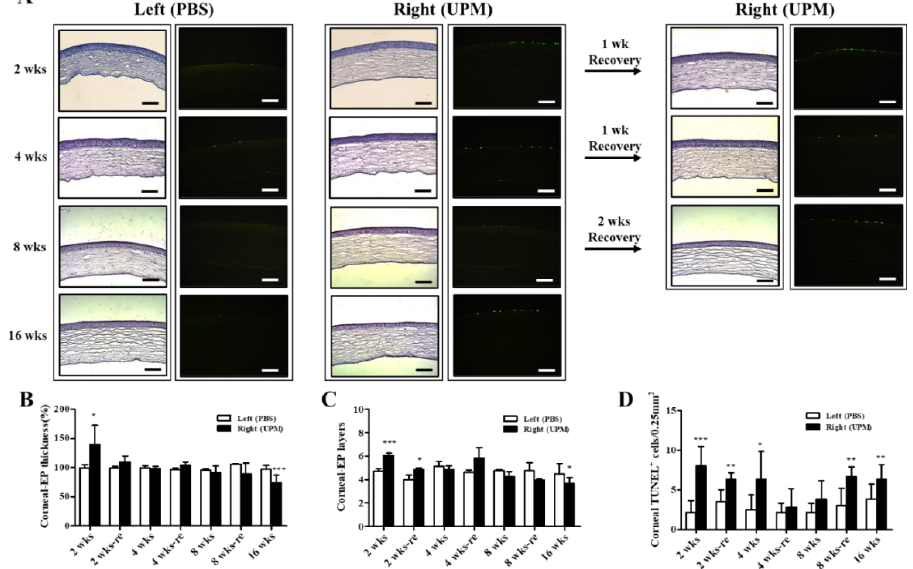
Figure 5. Effect of UPM exposure on corneal epithelial thickness and cell apoptosis according to exposure period. ( A ) Corneal images of hematoxylin and eosin (H&E) and terminal deoxynucleotidyl transferase dUTP nick end labeling (TUNEL) staining acquired at 200× magnification from all experimental periods are shown. The scale bars indicate 100 μm. The graphs of the relative thickness of corneal epithelium ( B ), the number of corneal epithelial layers ( C ) and the counts of apoptotic cells ( D ) are presented. Data are expressed as the mean ± SD. * p < 0.05, ** p < 0.01, *** p < 0.001 vs. left eye at the same time point.